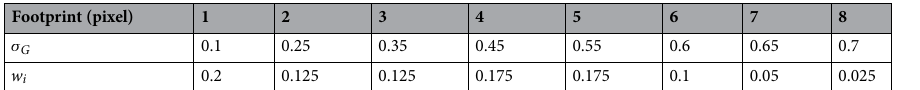
Table 1. Single photon charge cloud distribution. The table lists the single photon charge cloud distribution in terms of the pixel footprint, corresponding cloud width, and weighted probability for each case, used for model 2.